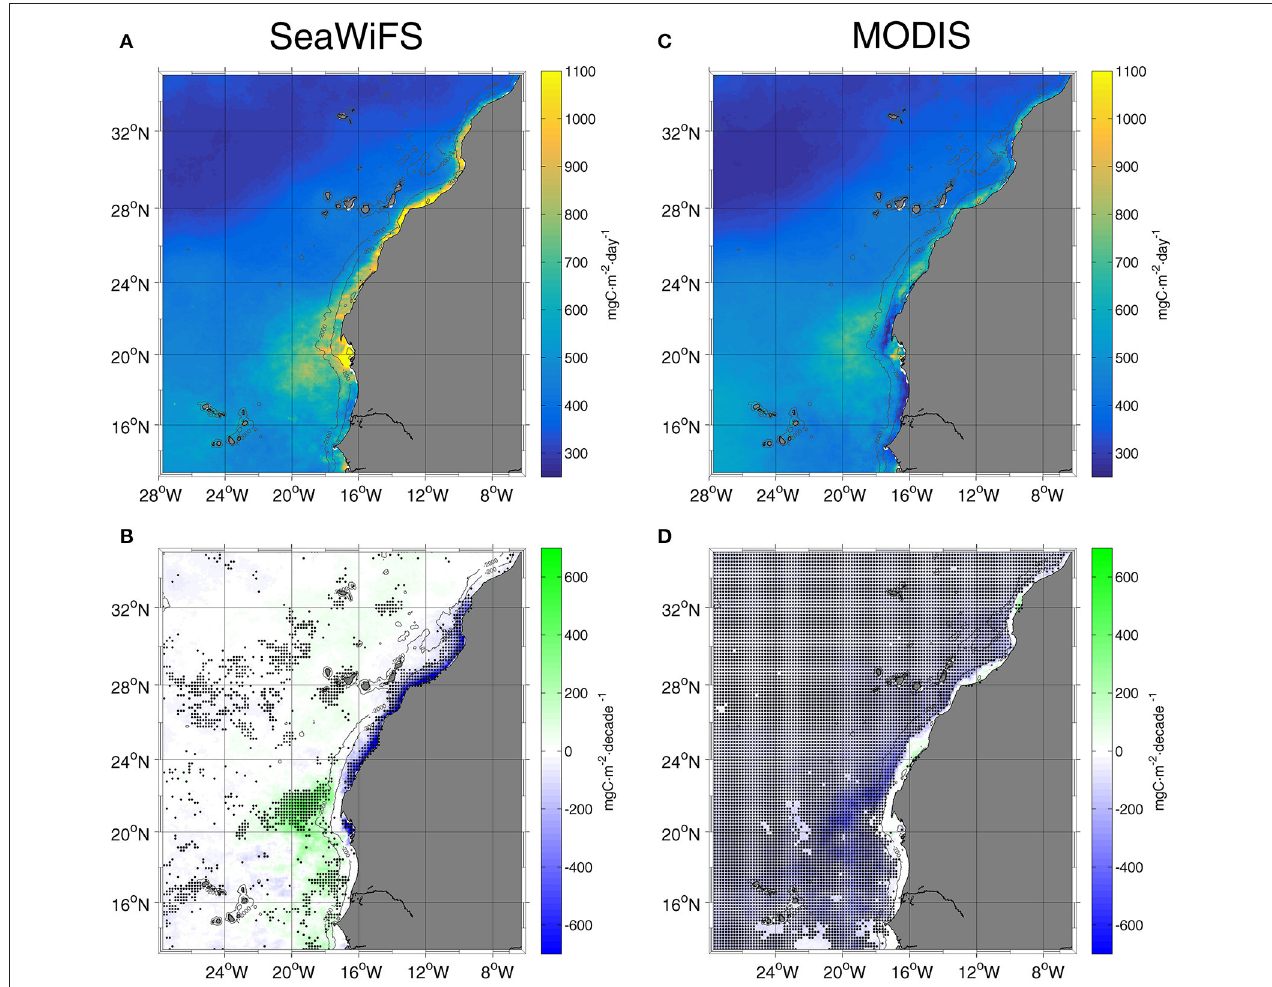
FIGURE 5 | From top to bottom, mean CbPM (A,C) and CbPM trend (B,D) maps for SeaWiFS (1998–2007, left column) and MODIS (2003–2015, right column) datasets. In (B,D) black dots correspond to significant trends ( p < 0.05). 200 and 2,000m isobaths are represented by contour